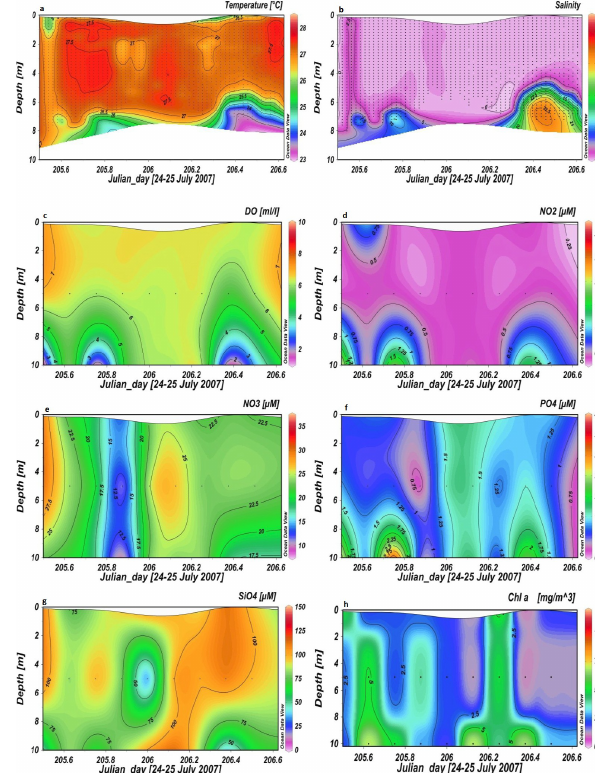
Fig. 6. Depth–time contours of salinity, temperature DO, chloro- phyll a , NO 2 , NO 3 , PO 3 , SiO 4 for every three hours from surface, 4 4 mid-depth and bottom during spring tide of wet season.